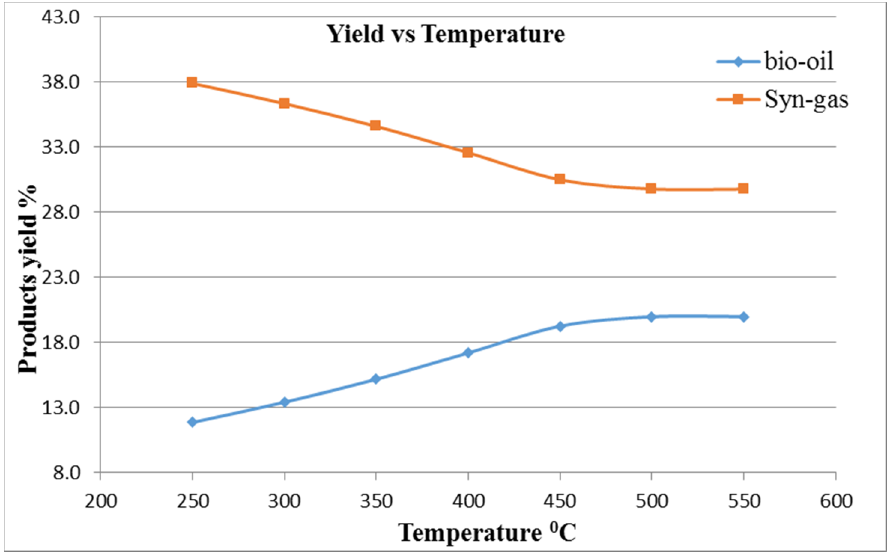
Figure 8. Yield products vs. temperature